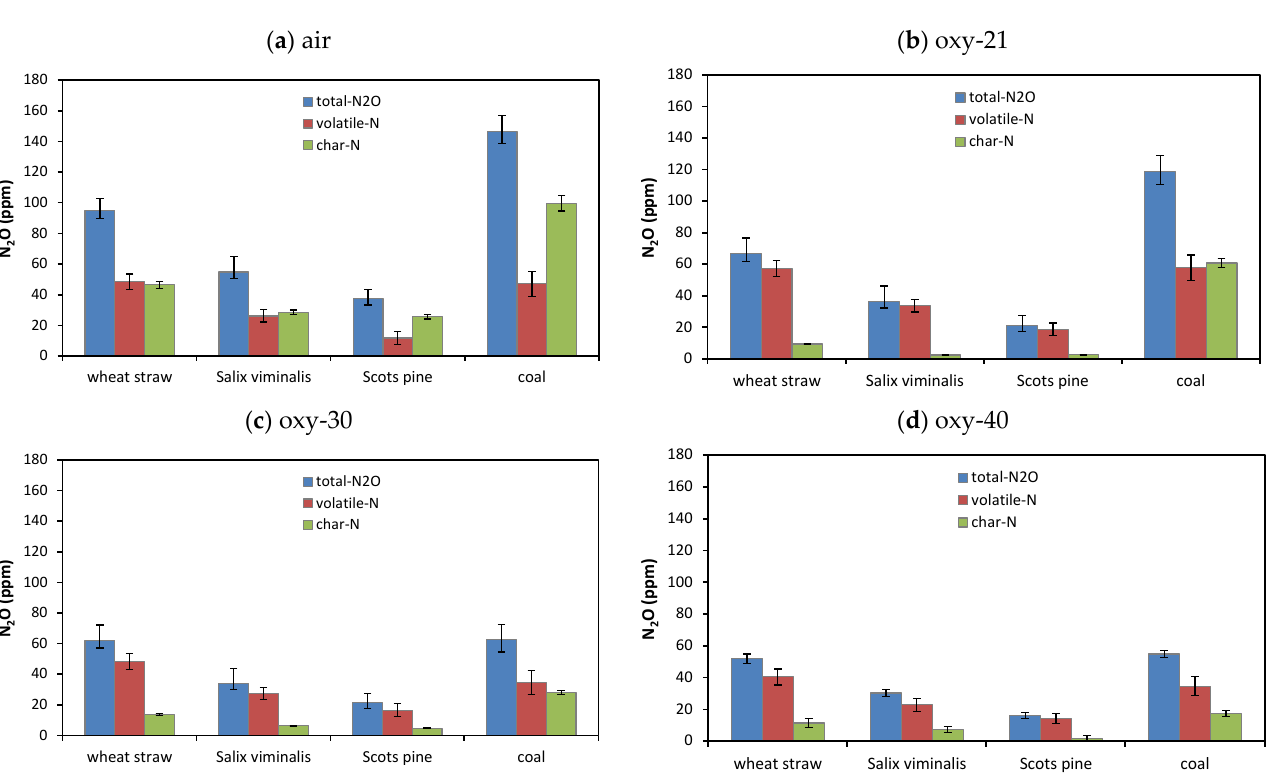
Figure 12. Effect of oxidizing atmosphere on N 2 O emissions during combustion. Vertical bars represent standard deviation.